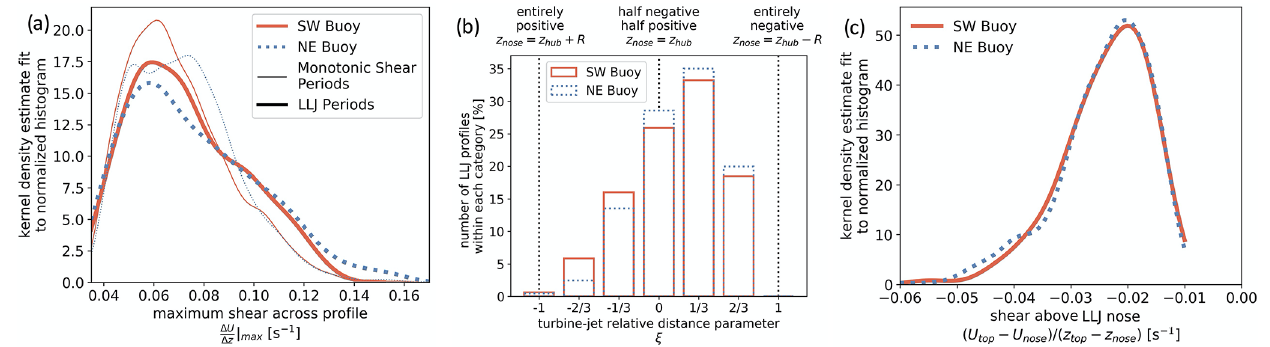
Figure 12. Distribution of maximum shear over 1 year of measured profiles and separated by profile type: monotonic vs. LLJ (a) ; distribution of turbine-jet relative distance parameter for all LLJ profiles (b) ; distribution of shear above LLJ nose (between nose and local wind speed minimum measured above it), shown only for 10min periods with LLJ profile (c) .